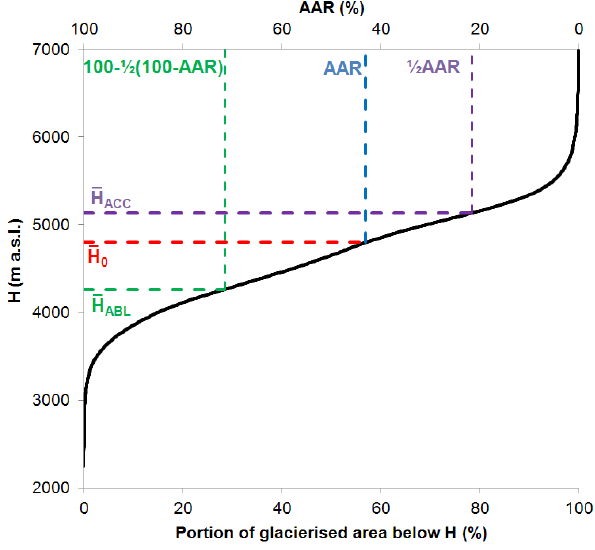
Fig. 6. Mean basin scale hypsometric curve (black line) for eleva- tion ( H ) and glacierized area of both basins. The blue dashed line Figure 6: Mean basin scale hypsometric curve (black line) for elevation ( H ) and glacierized 3 indicates how the accumulation area ratio (AAR) is derived using area of both basins. The blue dashed line indicates how the accumulation area ratio ( AAR ) is 4 the basin scale 0 o C isotherm ( H 0 , red dashed line) and the hyp- derived using the basin scale 0 o C isotherm ( H , red dashed line) and the hypsometric curve. 5 sometric curve. In this example H 0 = 4800ma.s.l. and the associ- 0 ated AAR = 43%. The median elevation of the accumulation area In this example H = 4800 m a.s.l. and the associated AAR = 43%. The median elevation of 6 0 ( H ACC ) is indicated by the purple dashed line and the median ele- the accumulation area ( H ) is indicated by the purple dashed line and the median elevation 7 vation of the ablation area ( H ABL ) is indicated by the green dashed ACC of the ablation area ( H ) is indicated by the green dashed line. 8 ABL